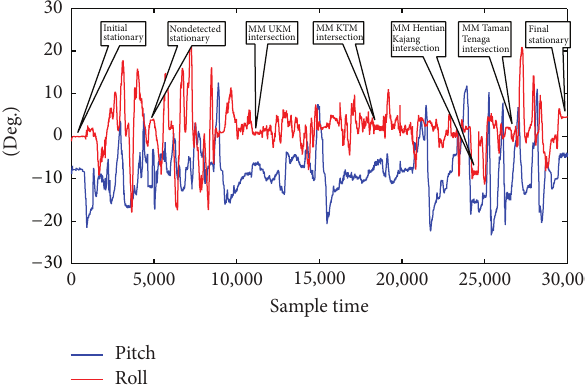
Figure 12: Stationary detection from pitch and roll signal in the first